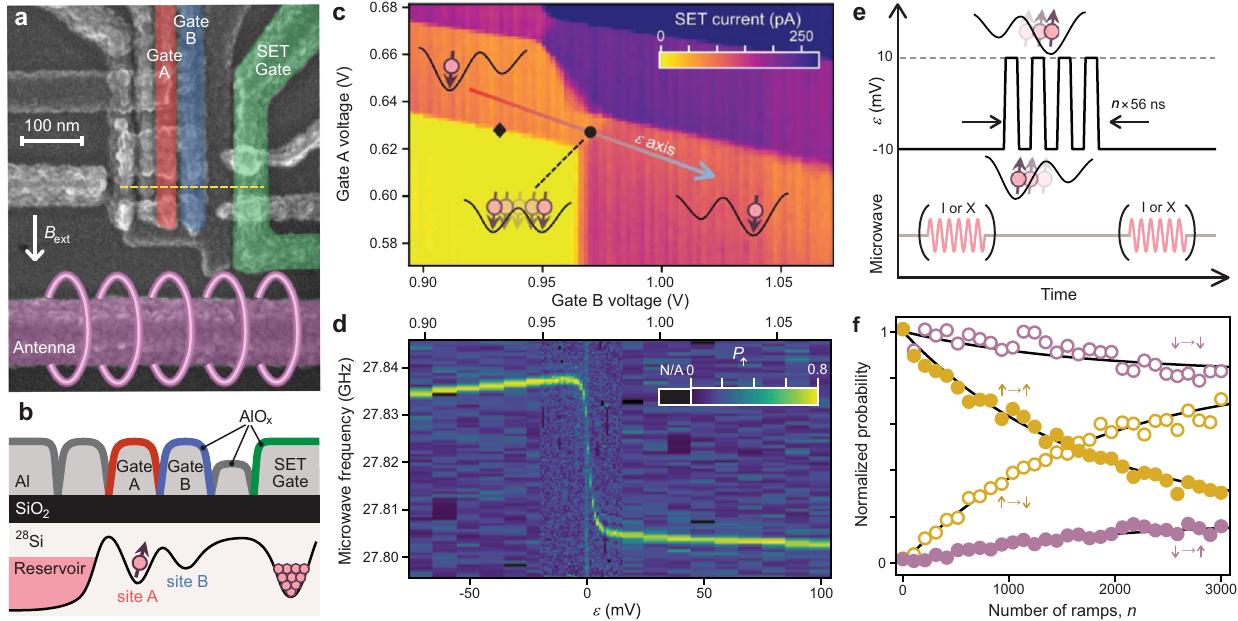
Fig. 1 Qubit device and spin polarization transfer. a False-colored scanning electron micrograph of an identical device. A linear array of quantum dots is formed in a silicon MOS structure underneath gates A (red) and B (blue). A single-electron transistor (SET) under gate SET (green) is used for charge sensing. Spin control is performed by applying a microwave pulse to an on-chip ESR antenna (magenta). The arrow indicates the direction of an in-plane external magnetic fi eld of 1 T (unless otherwise noted). b Cross-sectional schematic of the device. A single electron is loaded into quantum dot sites A and B and manipulated by gate-voltage pulses applied on aluminum metal gates A and B. c Stability diagram and de fi nition of the transfer axis. Charge con fi guration in the dot array is mapped through the SET current (a plane is subtracted). There are two and one charge transition lines for sites A and B, respectively, in the plotted area. The arrow de fi nes the gate-voltage axis used for qubit transport, ε . As ε is increased, the site where the electron resides changes from A to B. The interdot transition ( ε = 0) is marked by a circle. Spin initialization and readout is performed at the diamond using spin-dependent tunneling to the reservoir (see “ Methods ” section). d Gate-voltage dependence of the qubit resonance frequency. The probability of detecting " out of 100 events is measured after a 480 ns-long π pulse is applied. Data points with high reference signal (see “ Methods ” section) are plotted in black. The rapid change at the interdot transition reveals a 30 MHz interdot resonance frequency separation. e Pulse schematic used for polarization transfer fi delity experiment. 368 ns-long π pulses are turned on (X) and off (I) to prepare both " and # initial states and to measure the probabilities of fi nding " and # states after the transfers. The total time in the ramp pulse section increases by 56 ns for each additional ramp. f Normalized probabilities of fi nding " and # states for the " and # inputs. The solid curves are fi ts to the